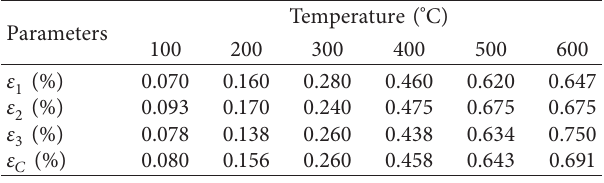
Table 2: Thermal expansion strains of concrete during heating under three-dimensional stress condition.